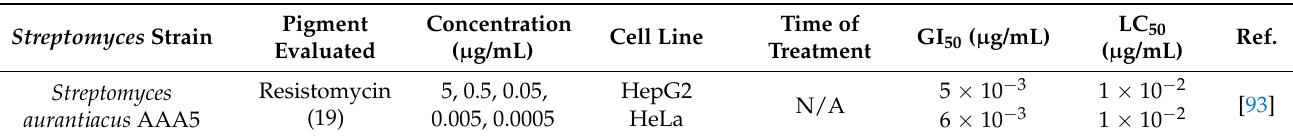
Table 11. GI 50 and LC 50 of Streptomyces -derived pigments and their conditions (cell lines and cell density, among others).